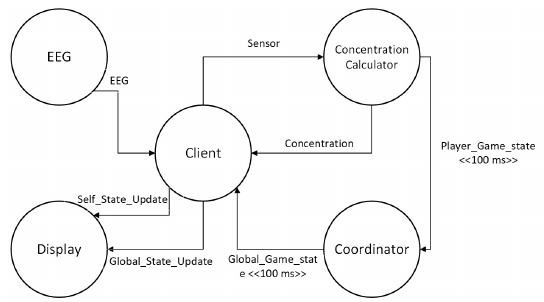
Figure 9. VRGame Application